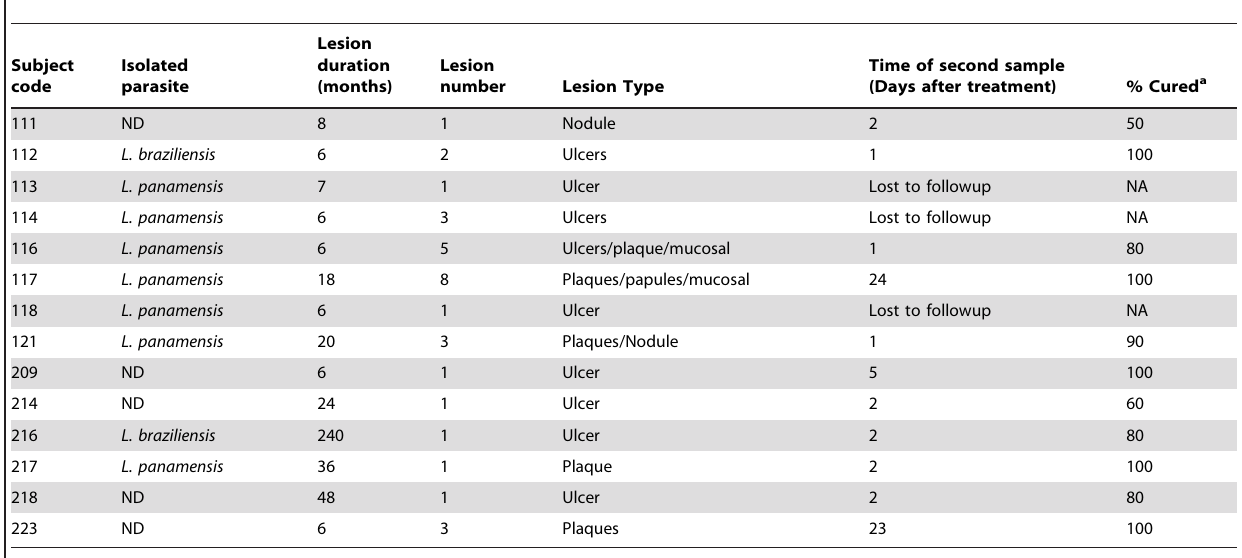
Table 1. Clinical characteristics and evolution of chronic dermal leishmaniasis patients.